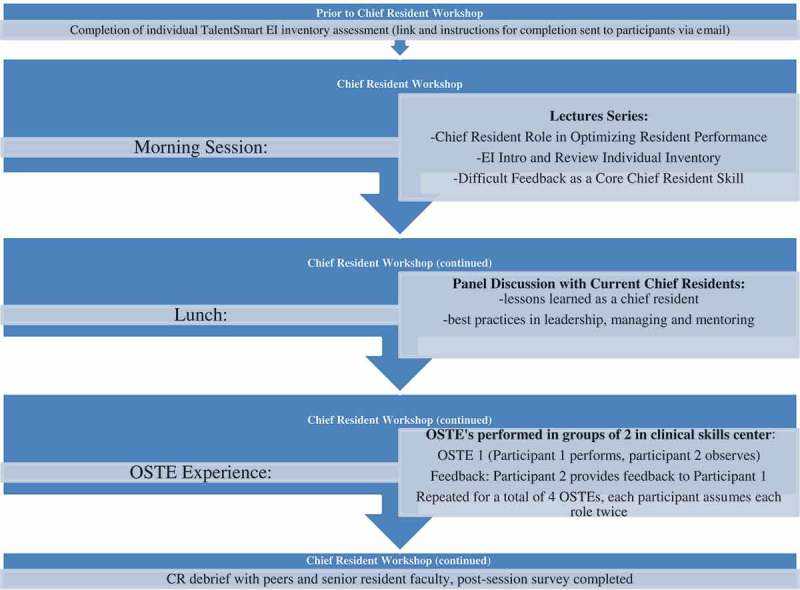
Outline of workshop.